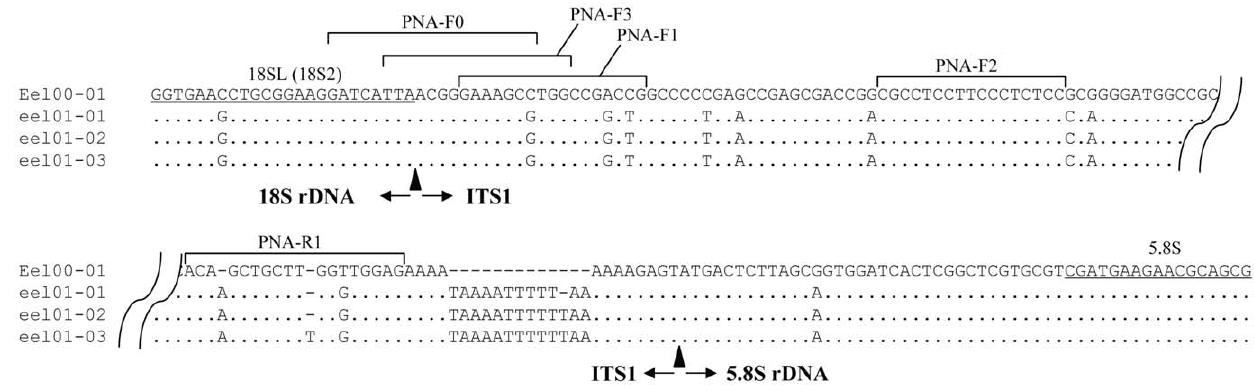
Figure 2. Sequence alignment among a common type clone (eel00-01) and three intra-individual variant clones (eel01-01 to -03). PCR primers (18SL and 5.8S) are underlined. The positions of five PNA probes (PNA-F0 to F3 and R1) are shown by a horizontal bracket. The sequences of all PNA but one (PNA-F3 having one mismatch) were fully complementary to those of eel00-01 (top sequence). PNA-F2 was fully complementary to all types. PNA-F0 and F3 were designed to have one and two substitutions against variant types, respectively. PNA-F1 and R1 were designed to have three substitutions against variant types.